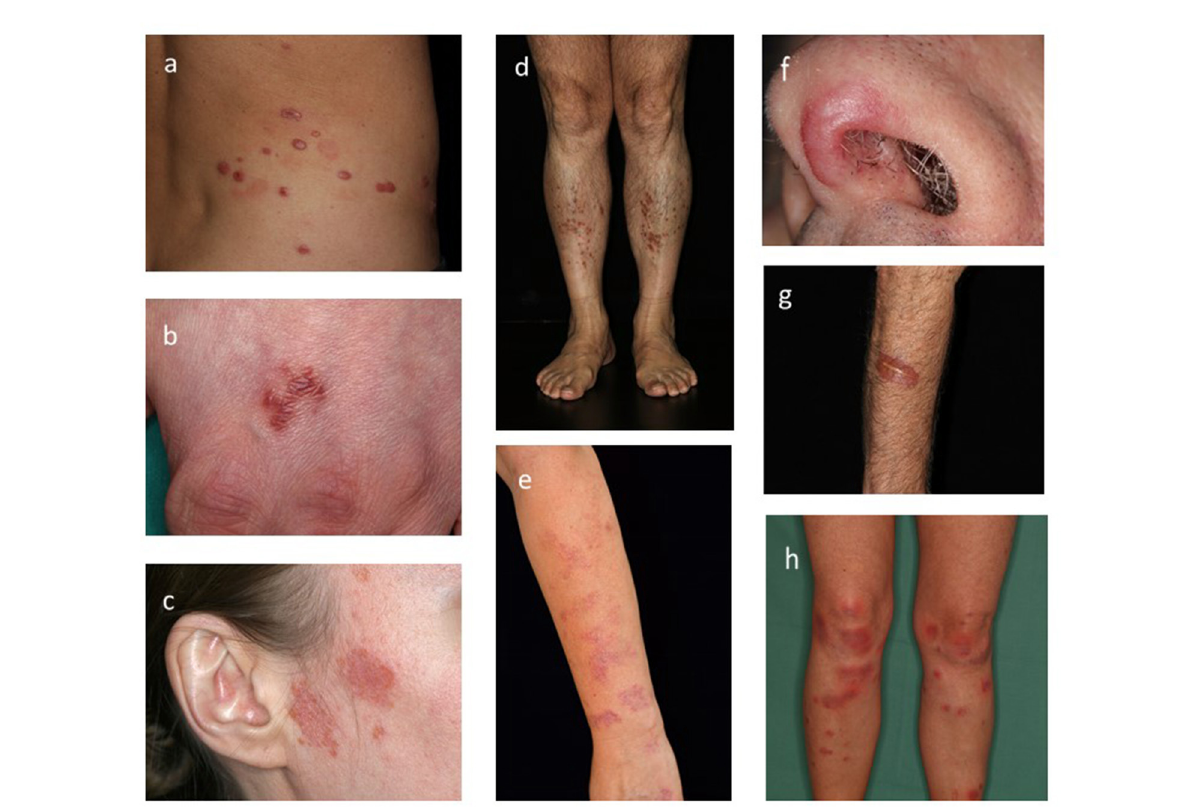
FIGURE1 Clinical hallmarks of cutaneous sarcoidosis. (a–g) Specific sarcoid skin lesions. (a) Multiple violaceous nodules on the trunk. (b) Solitary red-brown plaques on the back of the hand. (c) red atrophic plaques with slight epidermal involvement. (d) Multiple small red-brown papules on the lower leg. (e) Bright red colored macules non the arm. (f) Violaceous plaque on the nose (Lupus pernio). (g) Red plaque associated to a scar. (h) Non-specific skin lesion: tender erythematous nodules with subcutaneous infiltration on the ventral lower leg (Erythema nodosum).